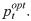
Simulation of the steady states with pt ∈ [0, 1].The red line is for the stunted while the blue line is for the children on treatment. Note that maximum T (minimum R) is achieved at the point pt = 0.51. This gives ptopt. The parameter values used are given in Table 1.